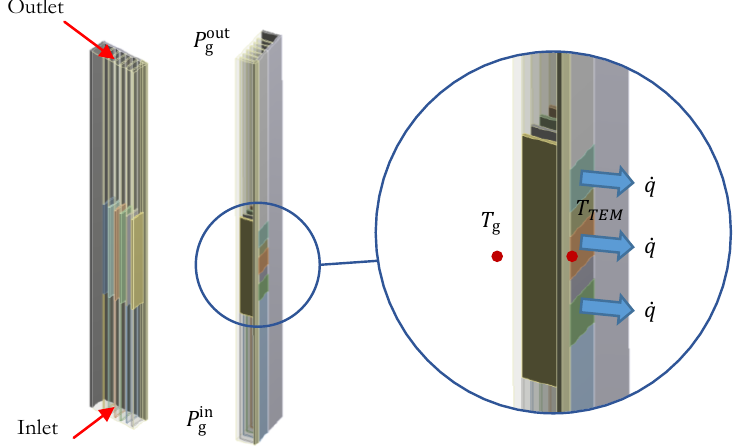
Figure 3. Boundary conditions used in the ANSYS Fluent